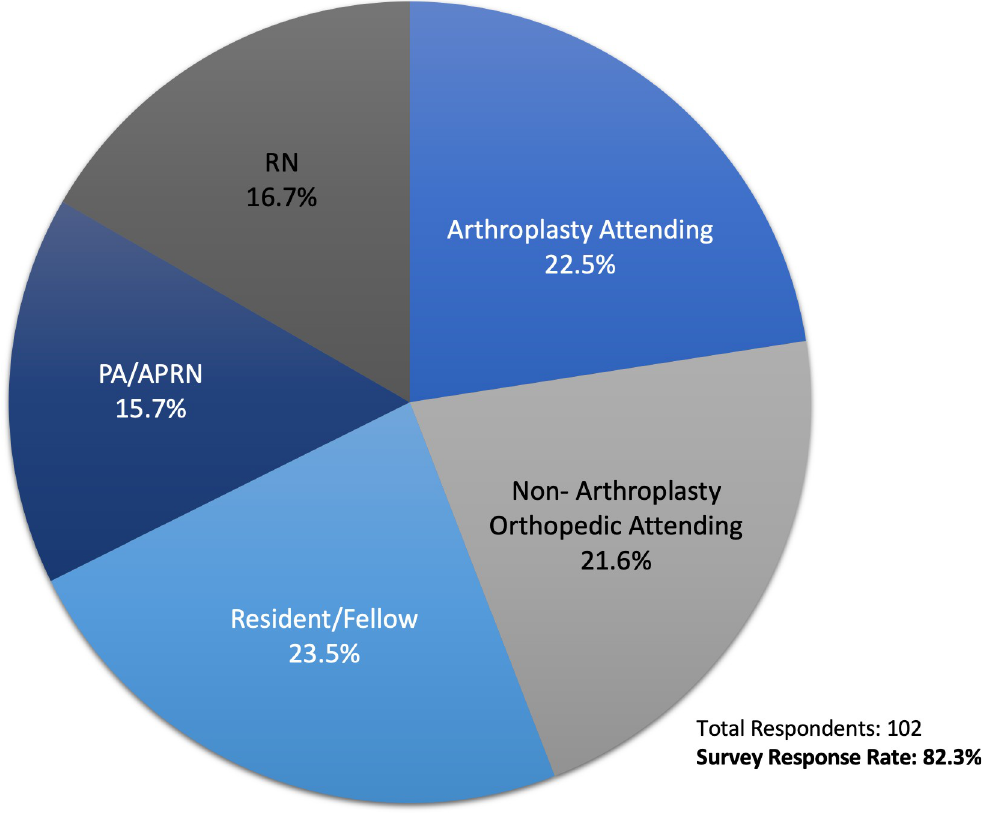
Fig 1. Survey respondents by training. Survey respondents by training level and